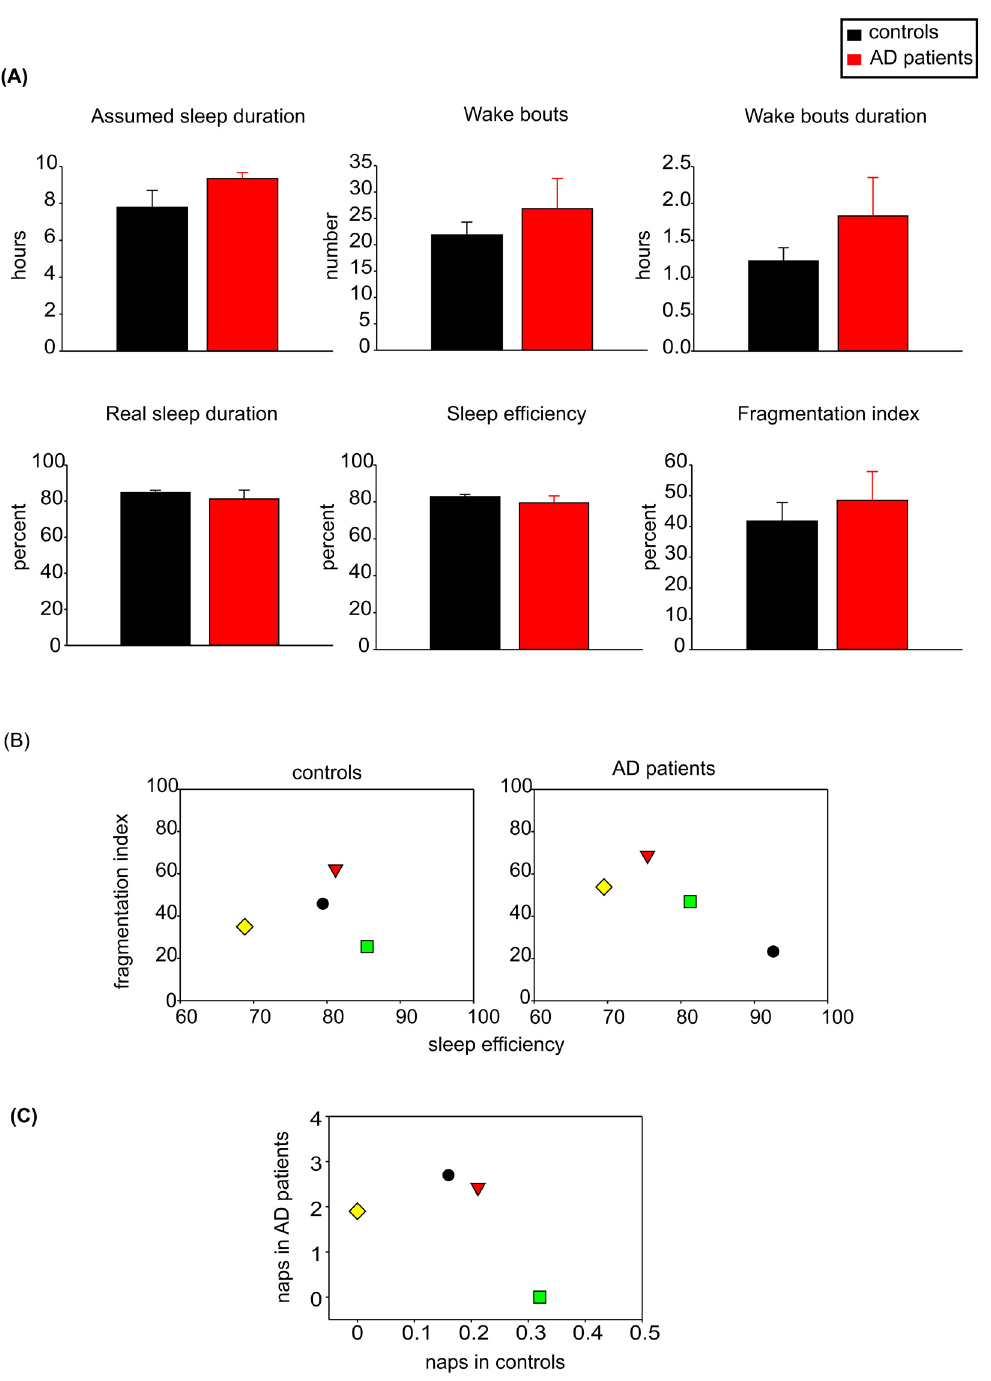
Fig 4. Nighttime sleep parameters and naps of controls and AD patients. (A) The nighttime sleep parameters (mean ± SEM), i.e., the length of the assumed sleep duration (hours), the number of awake episodes, the duration of awake episodes (hours), the real sleep duration (percent), the sleep efficiency (percent) and the fragmentation index (percent) were detected by Actiwatch analysis and compared between the group of 4 controls (black columns) and 4 AD patients (red columns); (B) The values of the sleep efficiencies and fragmentation indexes of the individual controls (left side) and AD patients (right side). For identification of the control/AD patients couples, the subjects of each couple are depicted with the same symbol (couple 1: yellow diamond, couple 2: black dot, couple 3: red triangle, couple 4: green square); (C) Mean number of daytime naps as detected by Actiwatch analysis (and confirmed by the sleep diaries records) for the control/AD patients couples. The symbols identifying the couples correspond to those depicting the nighttime sleep parameters in B). For more detail, see Material and Methods.